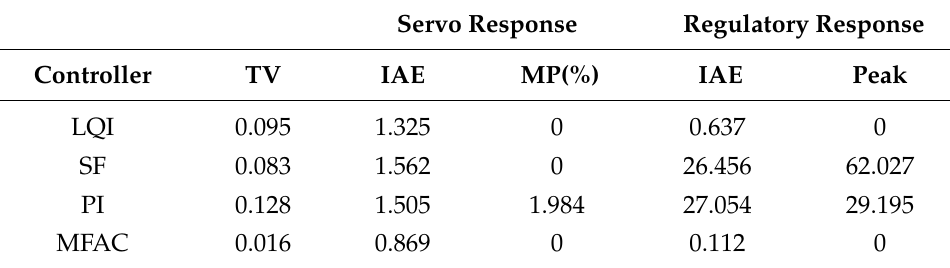
Table 2. Metrics of the nominal system ( D = 0.4374 and R o =